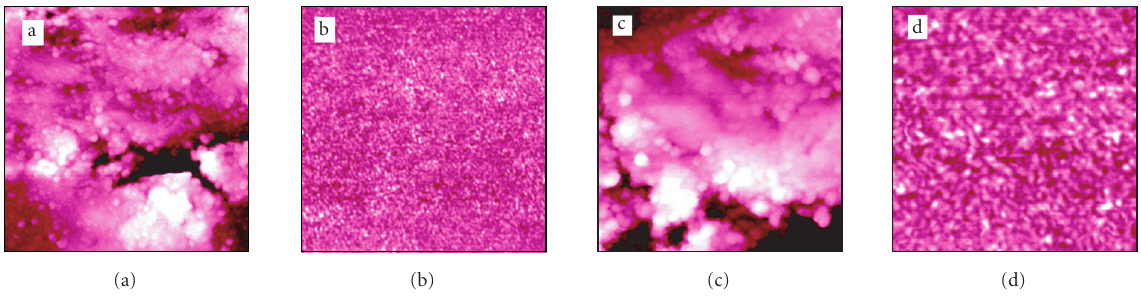
Figure 26: Shear-force AFM (a), (c) and apertureless SNOM (b), (d) of a HE-stained microtome cut of cancerous bladder cells: (a), (b) 25 μ m scan; (c), (d) 10 μ m scan; the Z range is 2 μ m in (a) and 1 μ m in (c).